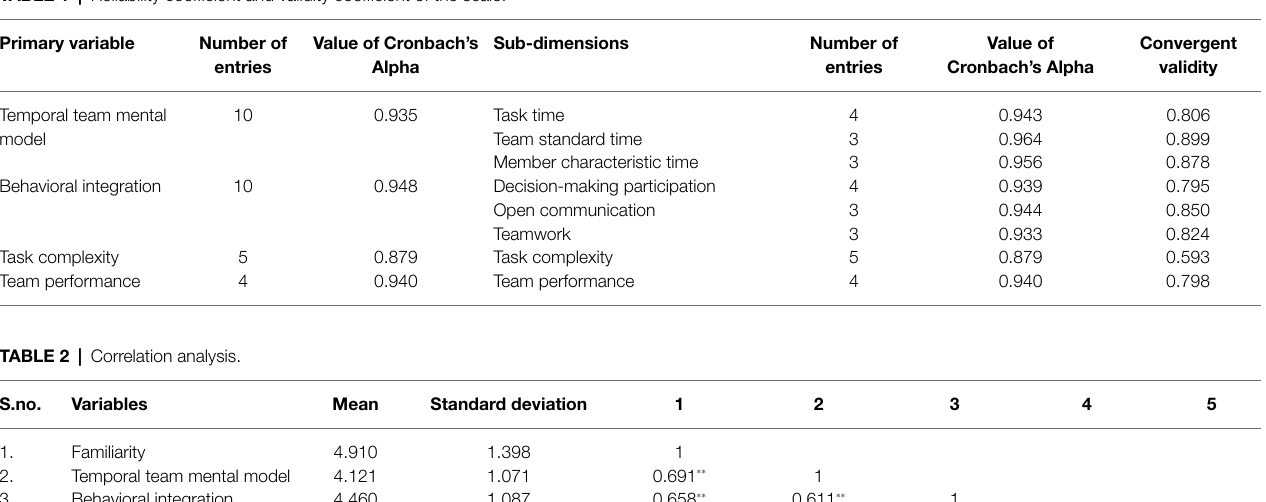
TABLE 1 | Reliability coefficient and validity coefficient of the scale.